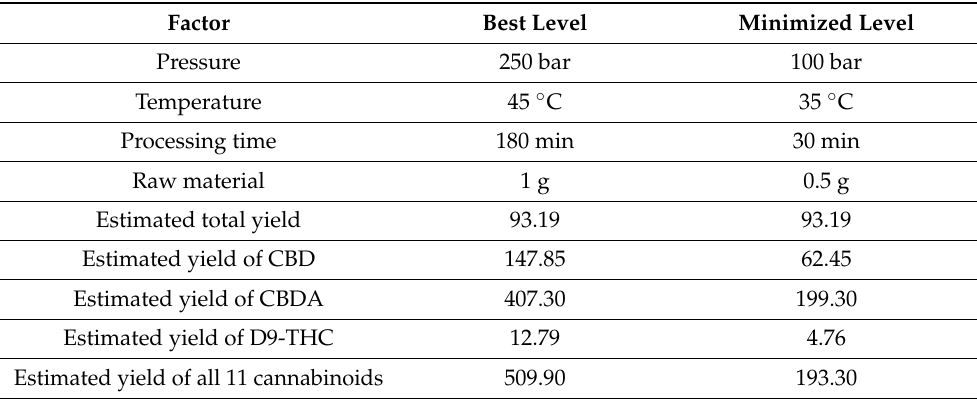
Table 9. Prediction for model validation.